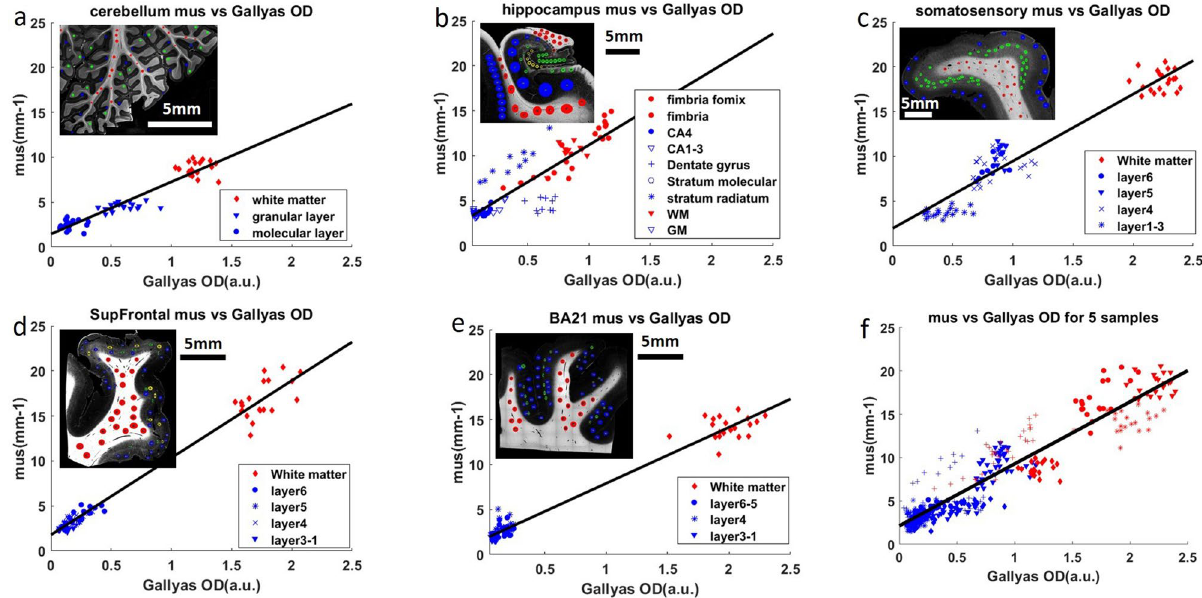
Figure 2. (a–e) Linear regression of µ s and Gallyas OD for 5 different regions in human brain samples. Red dots: white matter data points. Blue dots: grey matter data points. The inset figure shows the Gallyas OD map of the corresponding sample. The Red circles in the inset figure represent the ROIs in the white matter. The blue, green and yellow circles represent the ROIs in different layers of the grey matter, for example, the green ROIs in (c) represent infragranular layers and the blue ROIs represent the supragranular layers. (a) Cerebellum, (b) hippocampus, (c) somatosensory cortex, (d) superior frontal cortex (SupFrontal), (e) middle temporal Brodmann area 21(BA21), (f) linear regression of all data points from 5 samples. The six panels have the same range on the X and Y axes for easier